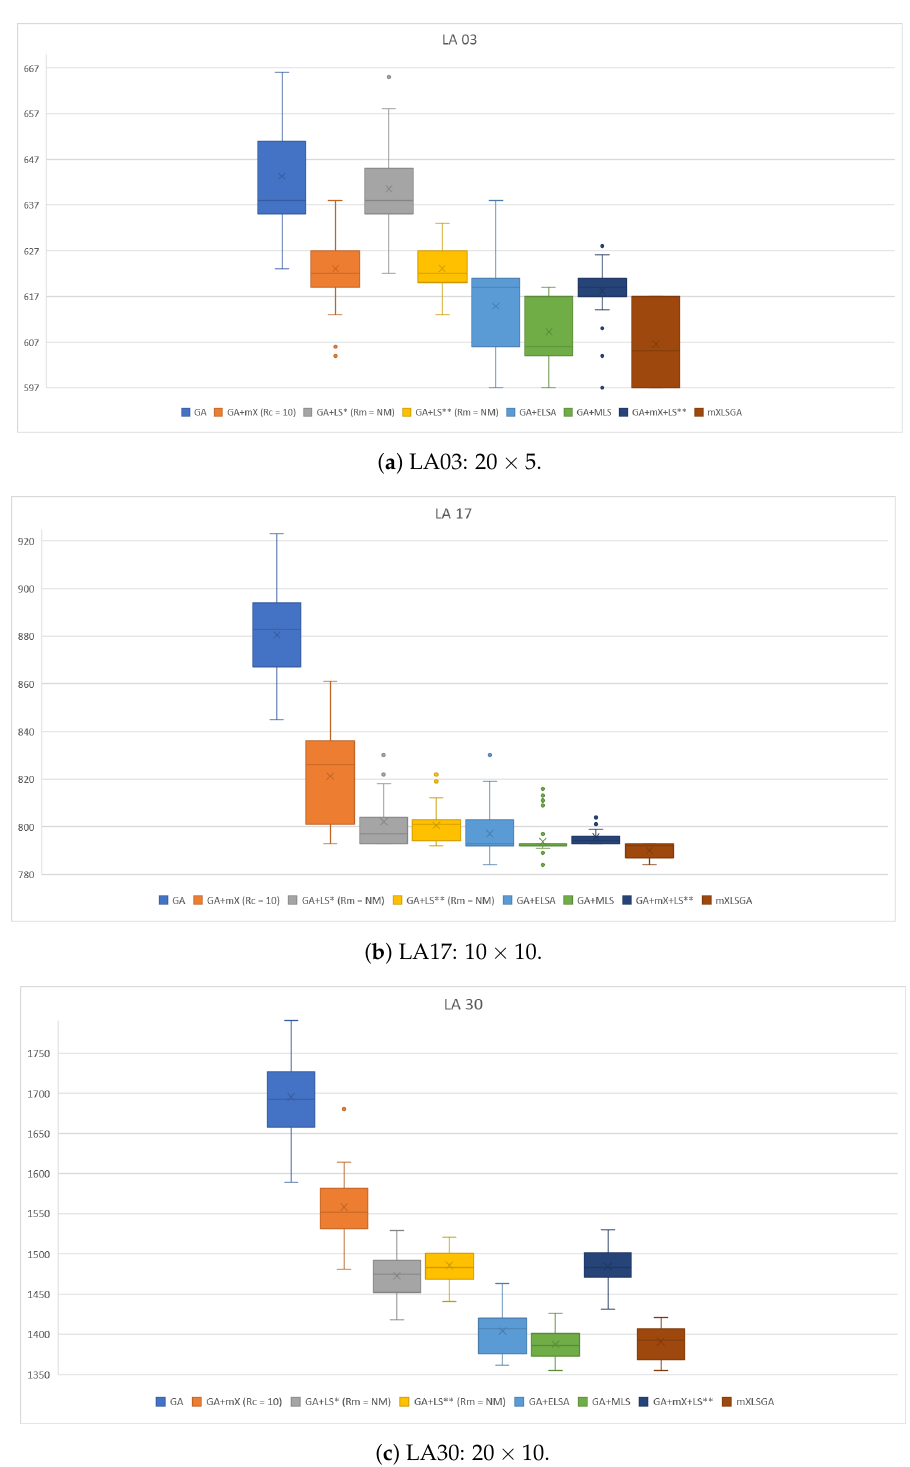
Figure 5. Box plots of the fitness values of 35 executions of the different configuration of our